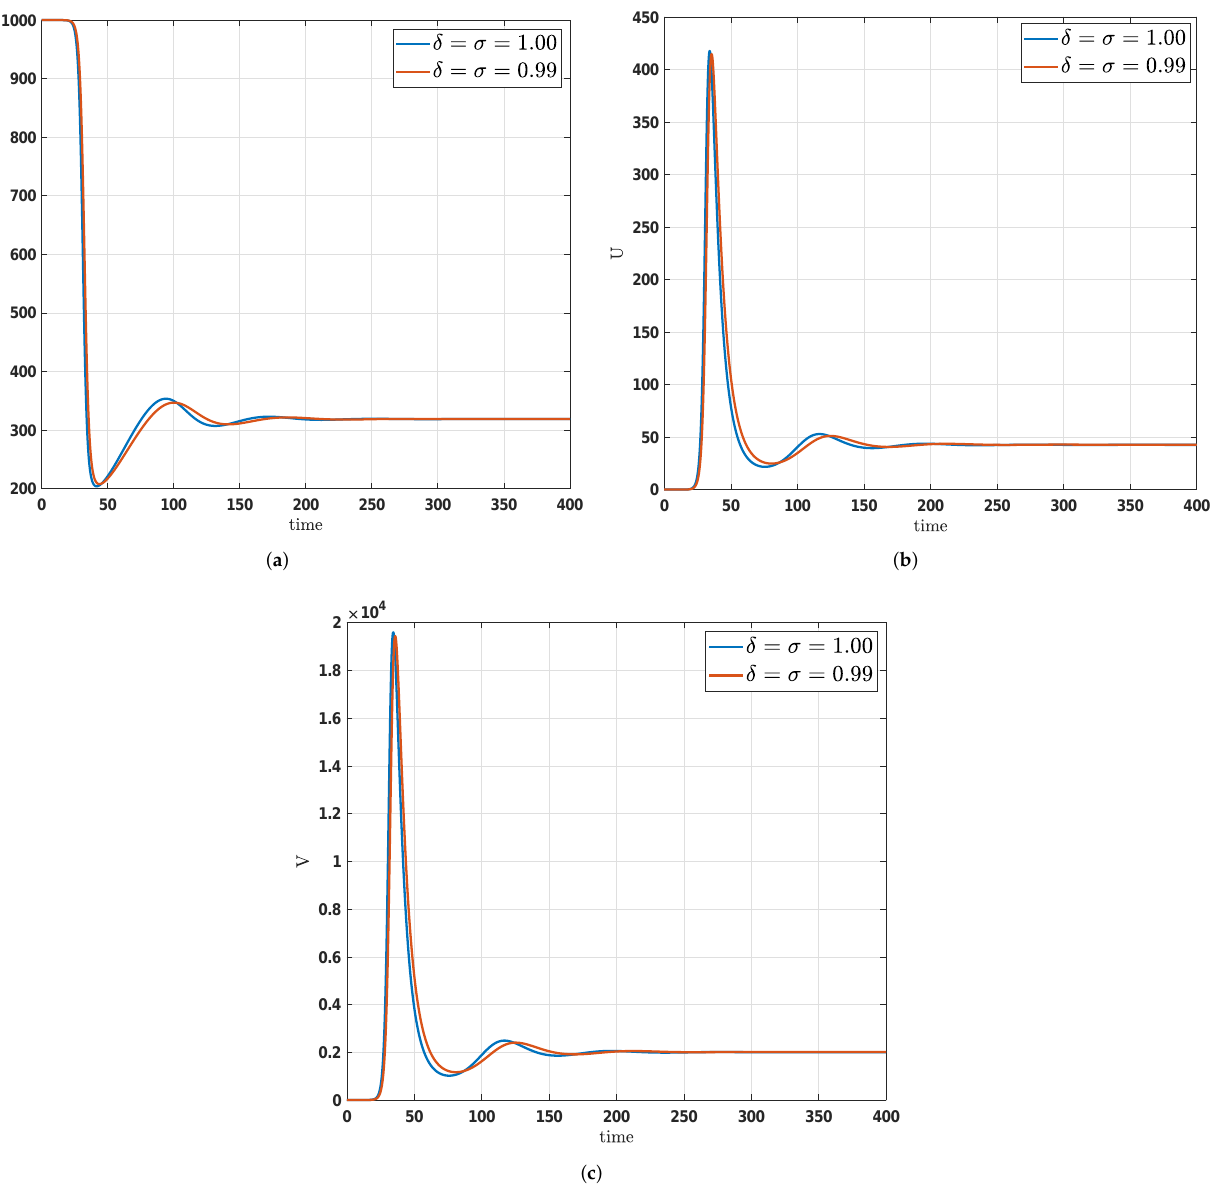
Figure 2. Numerical trajectories by varying both fractal order and fractional orders δ = σ = 1.00,0.99 via the Adams-Bashforth method. ( a ) A 0.01-variation in fractal-fractional orders of susceptible CD4 + T-cells. ( b ) A 0.01-variation in fractal-fractional orders of infectious CD4 + T-cells. ( c ) A 0.01-variation in fractal-fractional orders of free particles of the infection of the HIV-1 virus in the